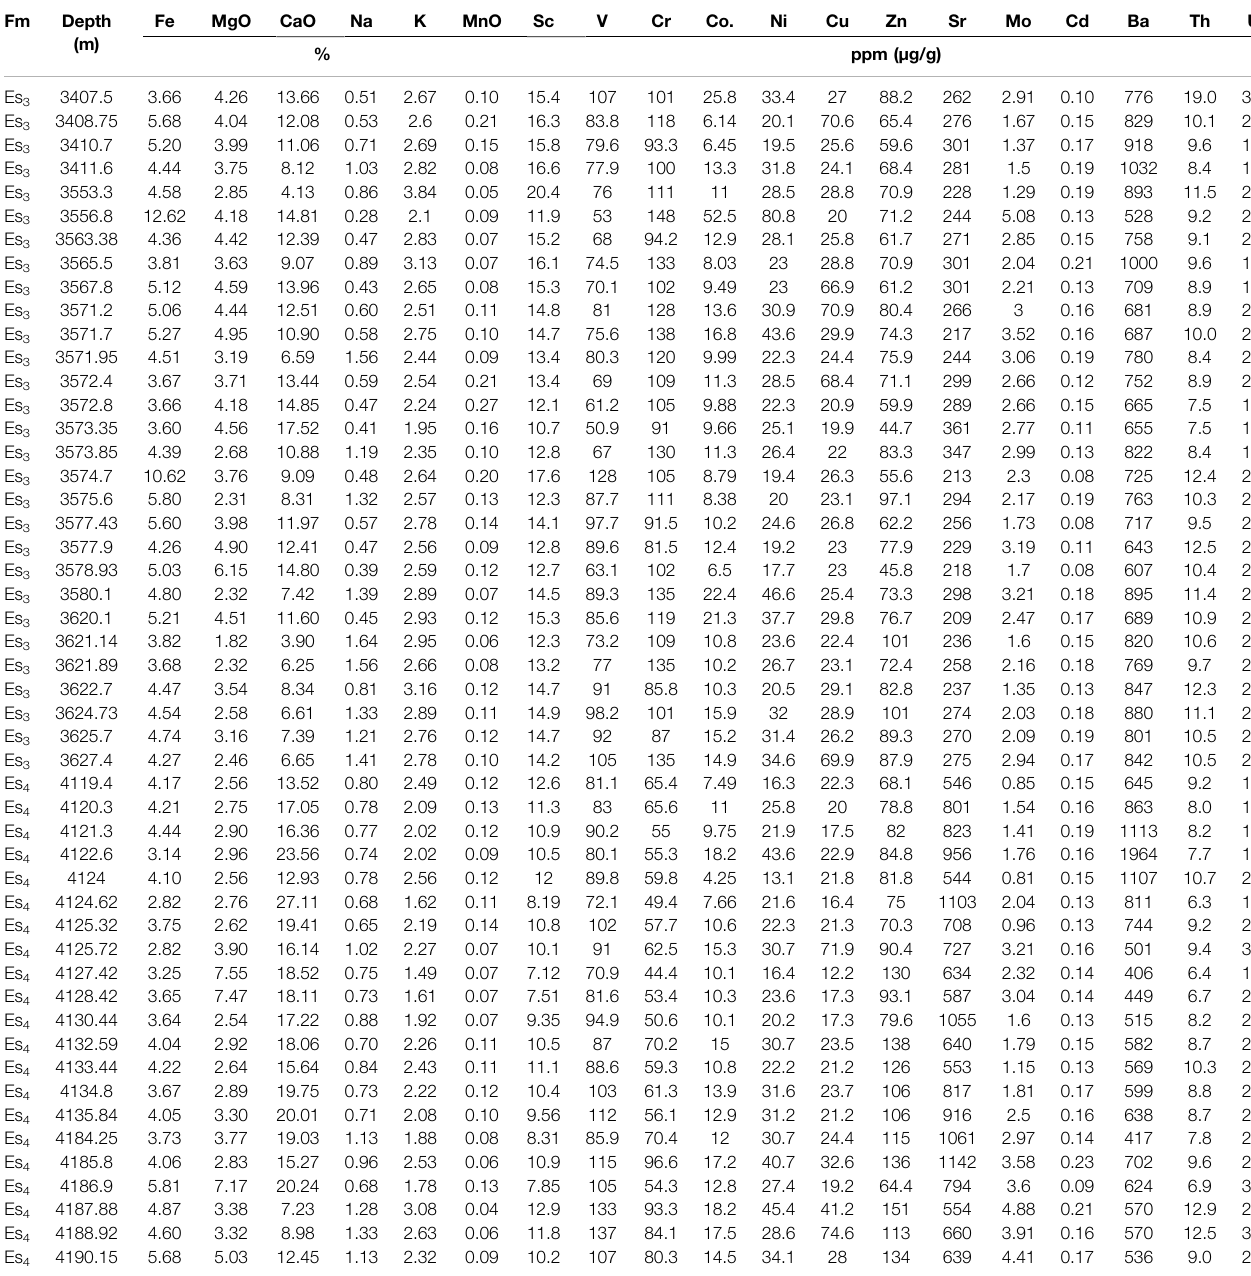
TABLE 2 | Some major element concentrations and trace element concentrations of Es 3 and Es 4 mudstone in the Langgu sag. Fm Depth (m)